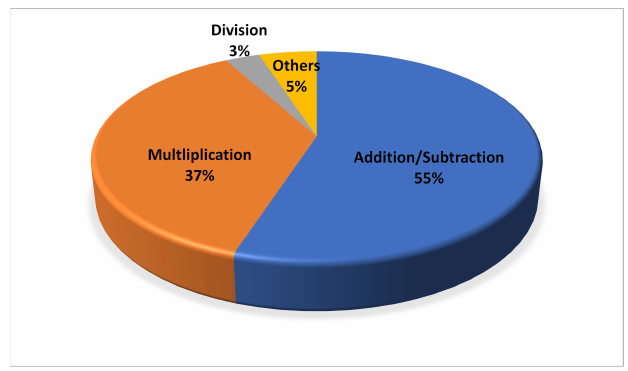
Figure 1. Distribution of floating-point instructions